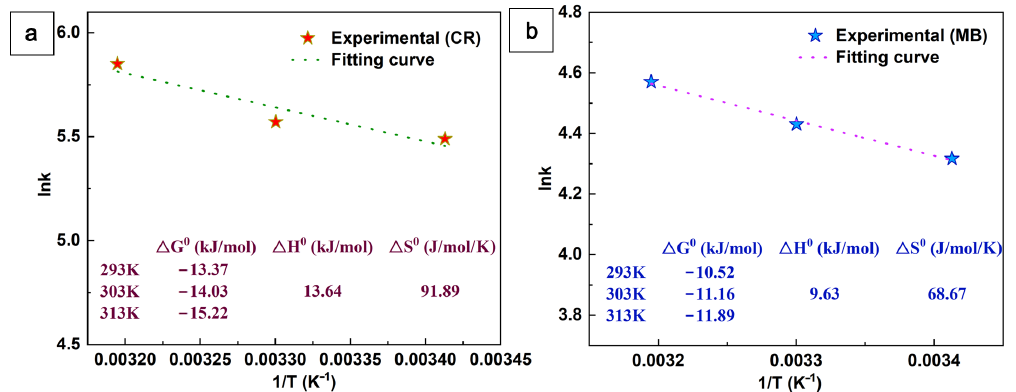
Figure 9. Plots of lnk against 1/T for the adsorption of CR ( a ) and MB ( b ) onto aerogel.